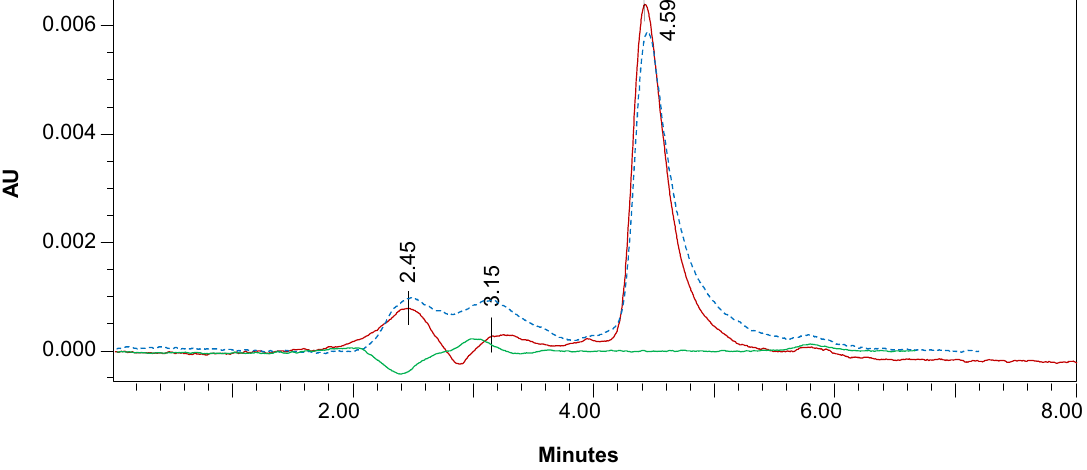
Table 1. Statistical analysis of the calibration curves of risedronate.